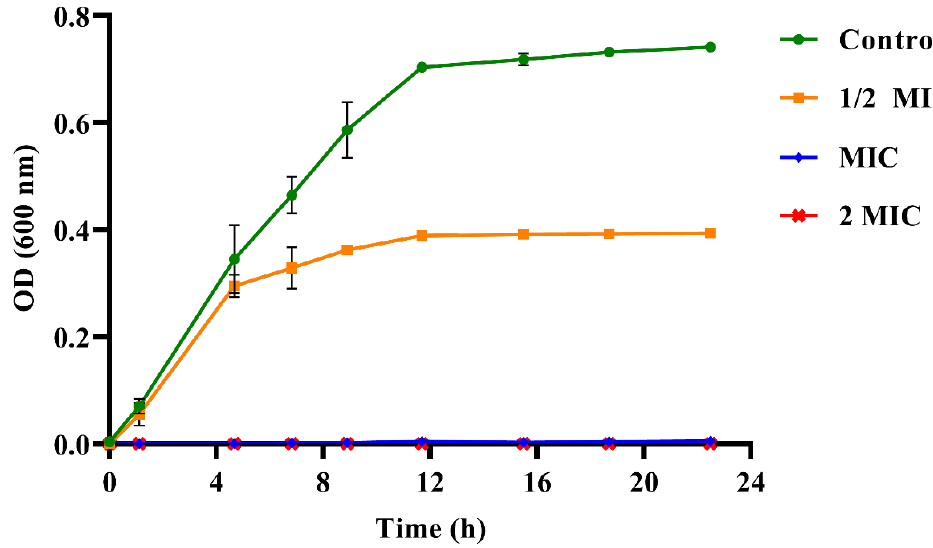
Figure 1. The growth curve of S. mutans with or without propolis essential oil (PEO) treatment. Error bars indicate the standard error of the mean; where error bars are not visible, they are smaller than the symb ol. 1/2MIC, 0.3125 μL/mL; MIC, 0.625 μL/mL; 2MIC, 1.25 μL/mL.